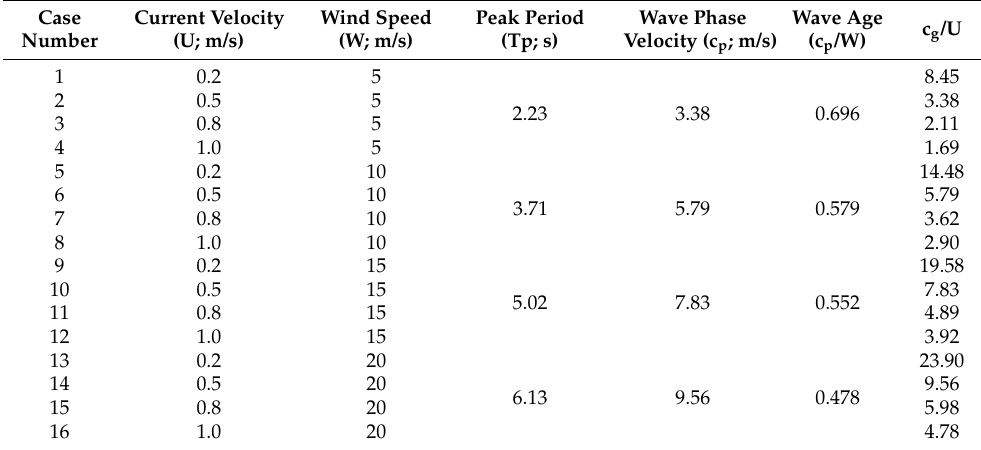
Table 1. Experimental